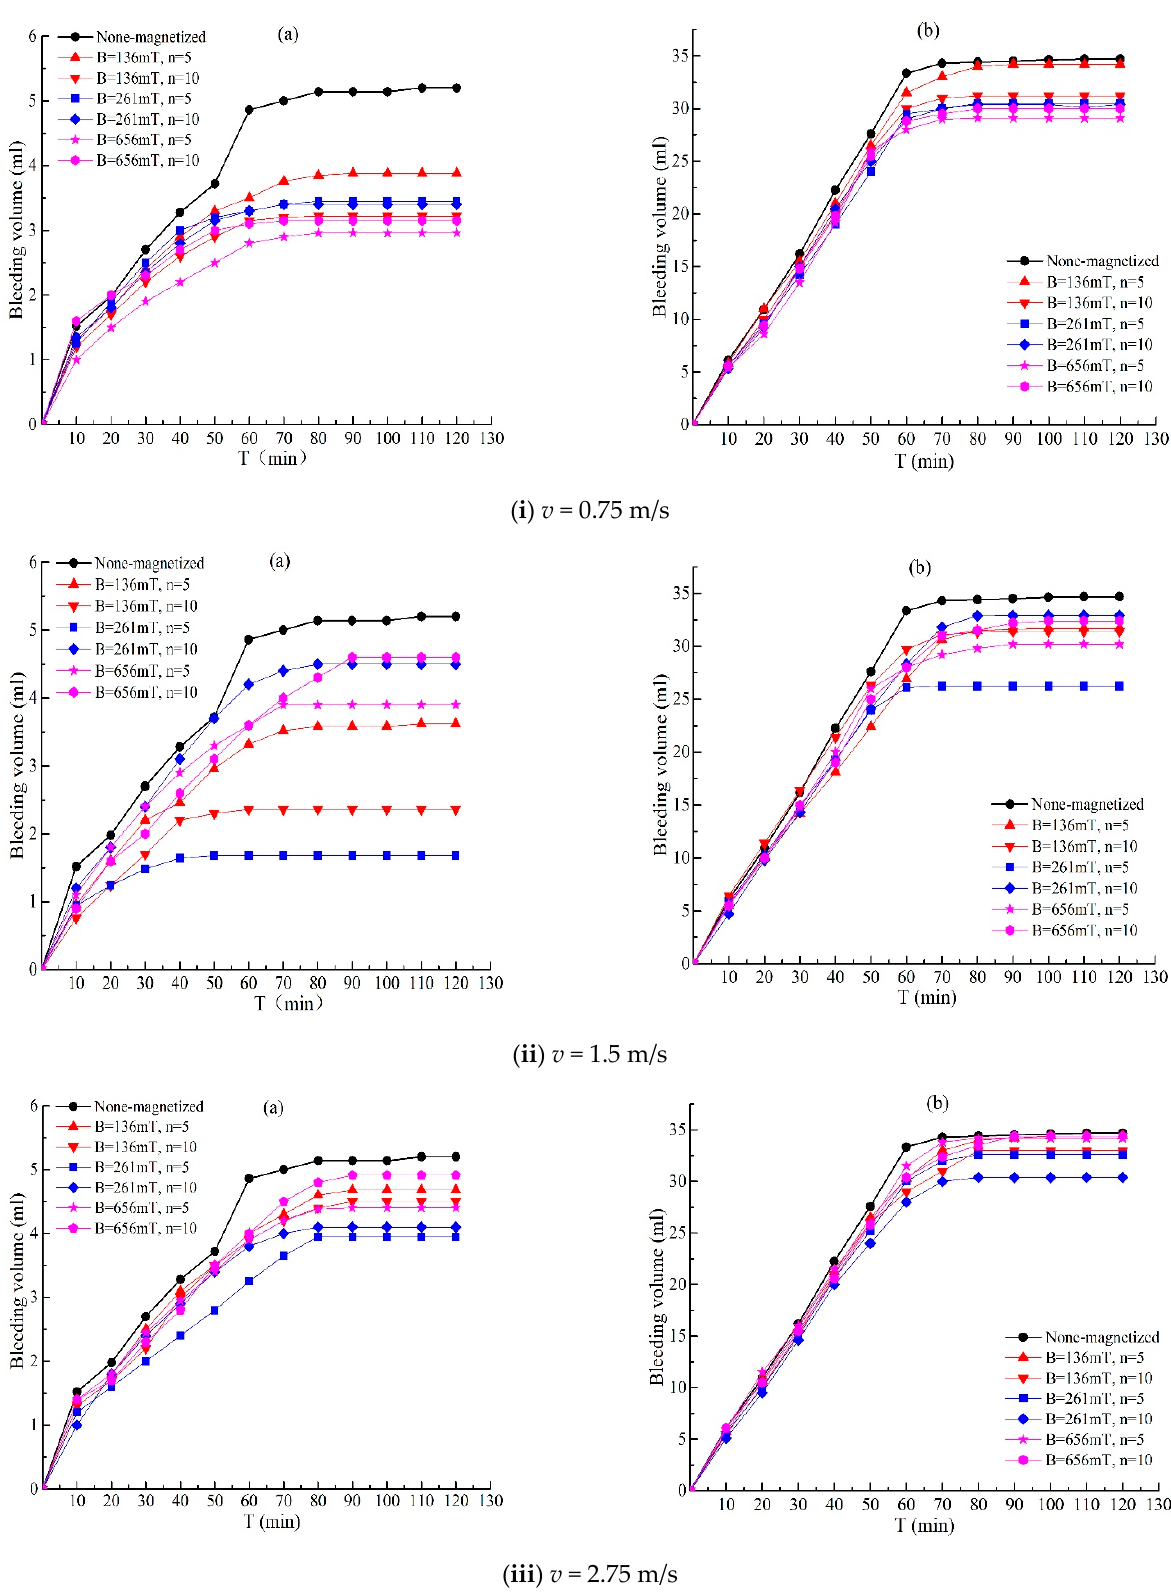
Figure 10. Bleeding volume of cement grouts under different magnetic conditions (environment temperature 20 ± 1 °C, ( a ) water–cement ratios ( w/c ) ratio 0.5:1, ( b ) w/c ratio 1:1).